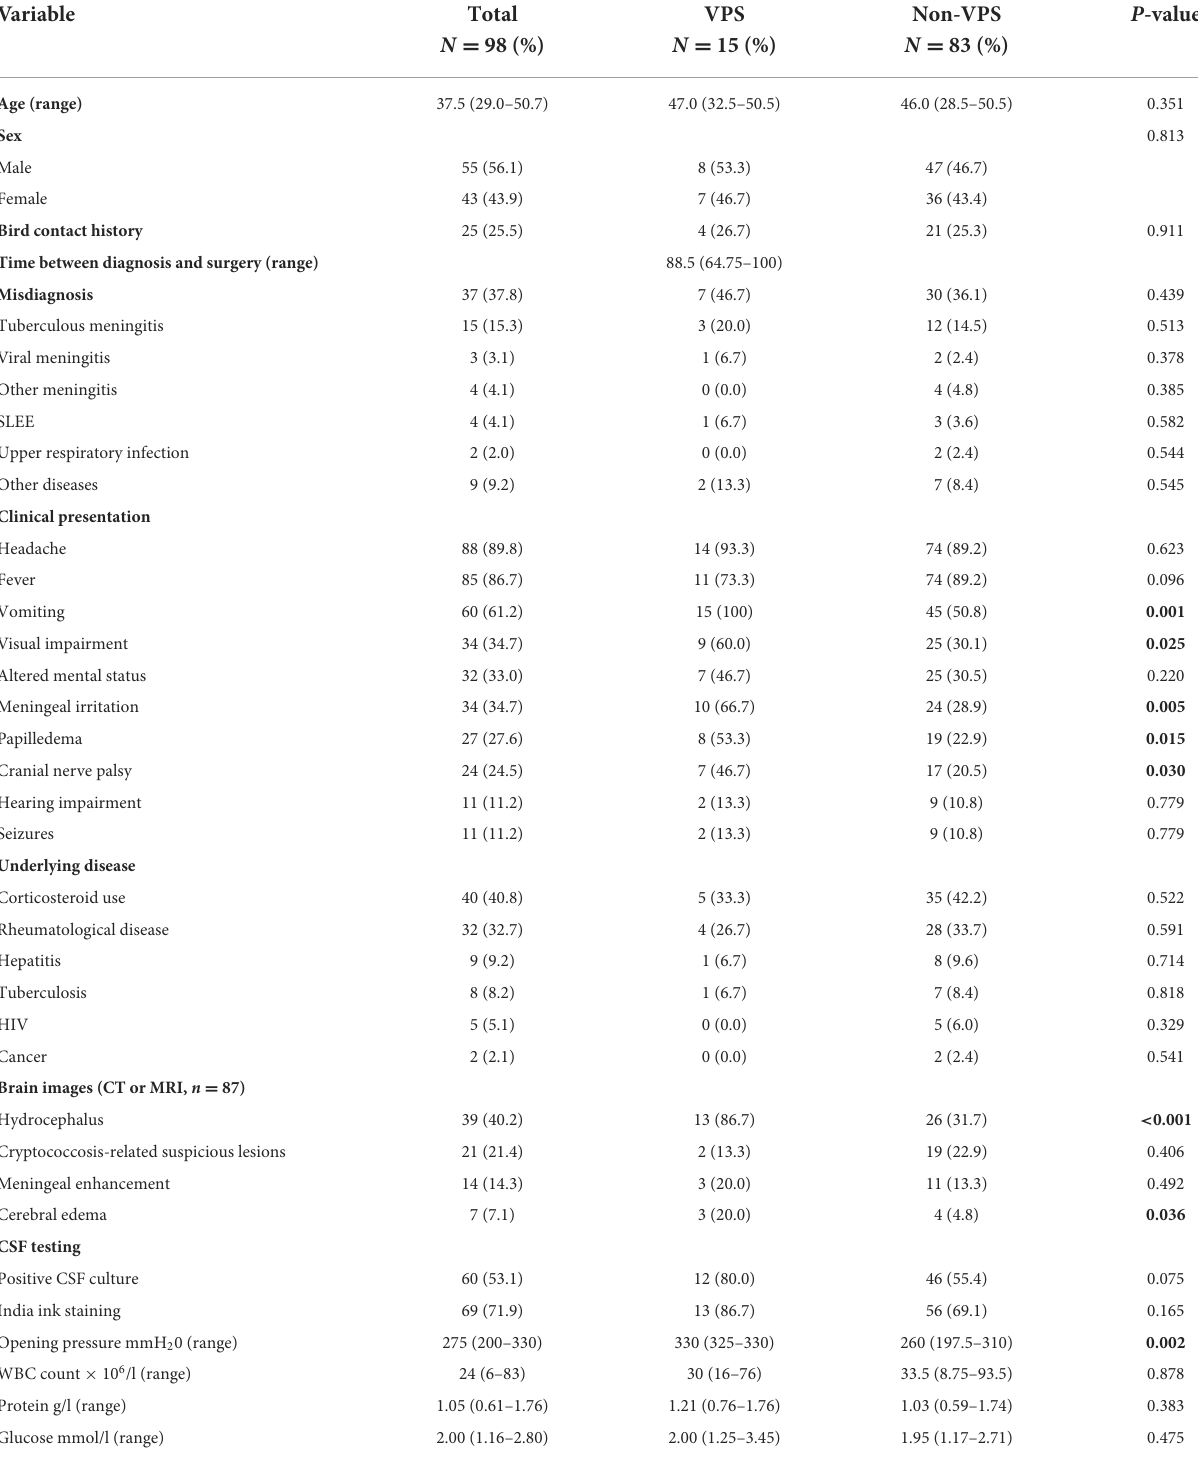
TABLE 1 Clinical characteristics of patients with